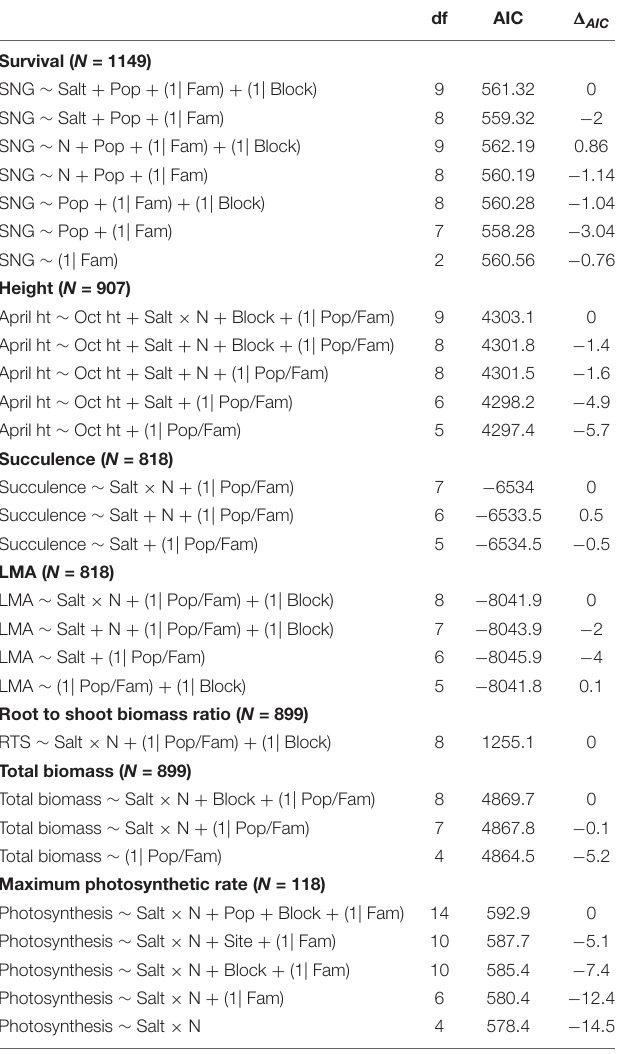
TABLE 1 | Model selection based on a series of models using the General Linear Model (GLM) or Generalized Linear-Mixed-Model (GLMM) framework. df AIC (cid:49)